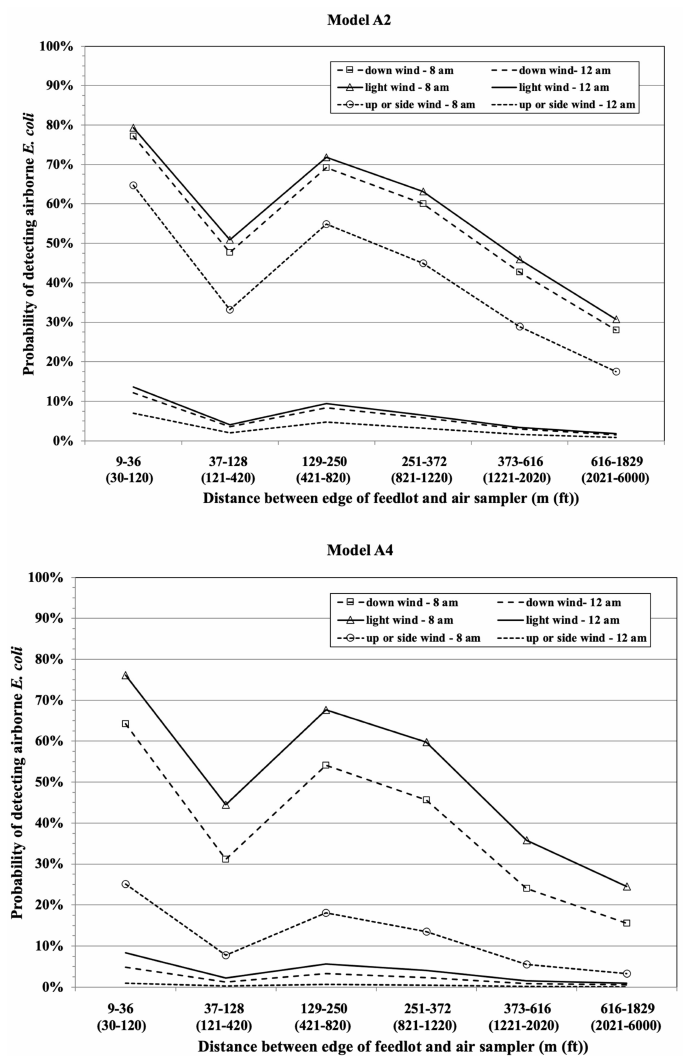
Figure 5. Predicted probability of detecting airborne E. coli as a function of distance to a commercial feedlot, Models A2 and A4 used in situ and a nearby weather station for meteorological data,